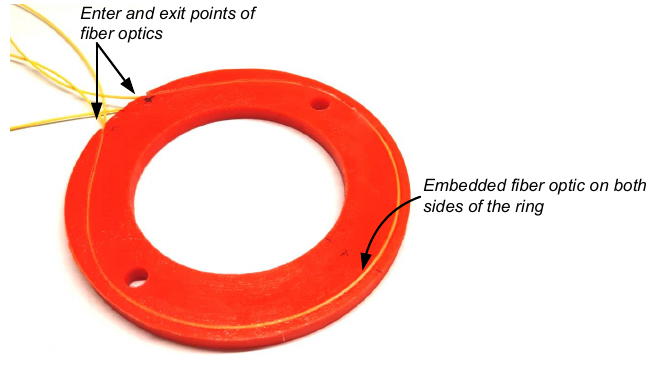
Figure 5. Fiber optic-embedded confining